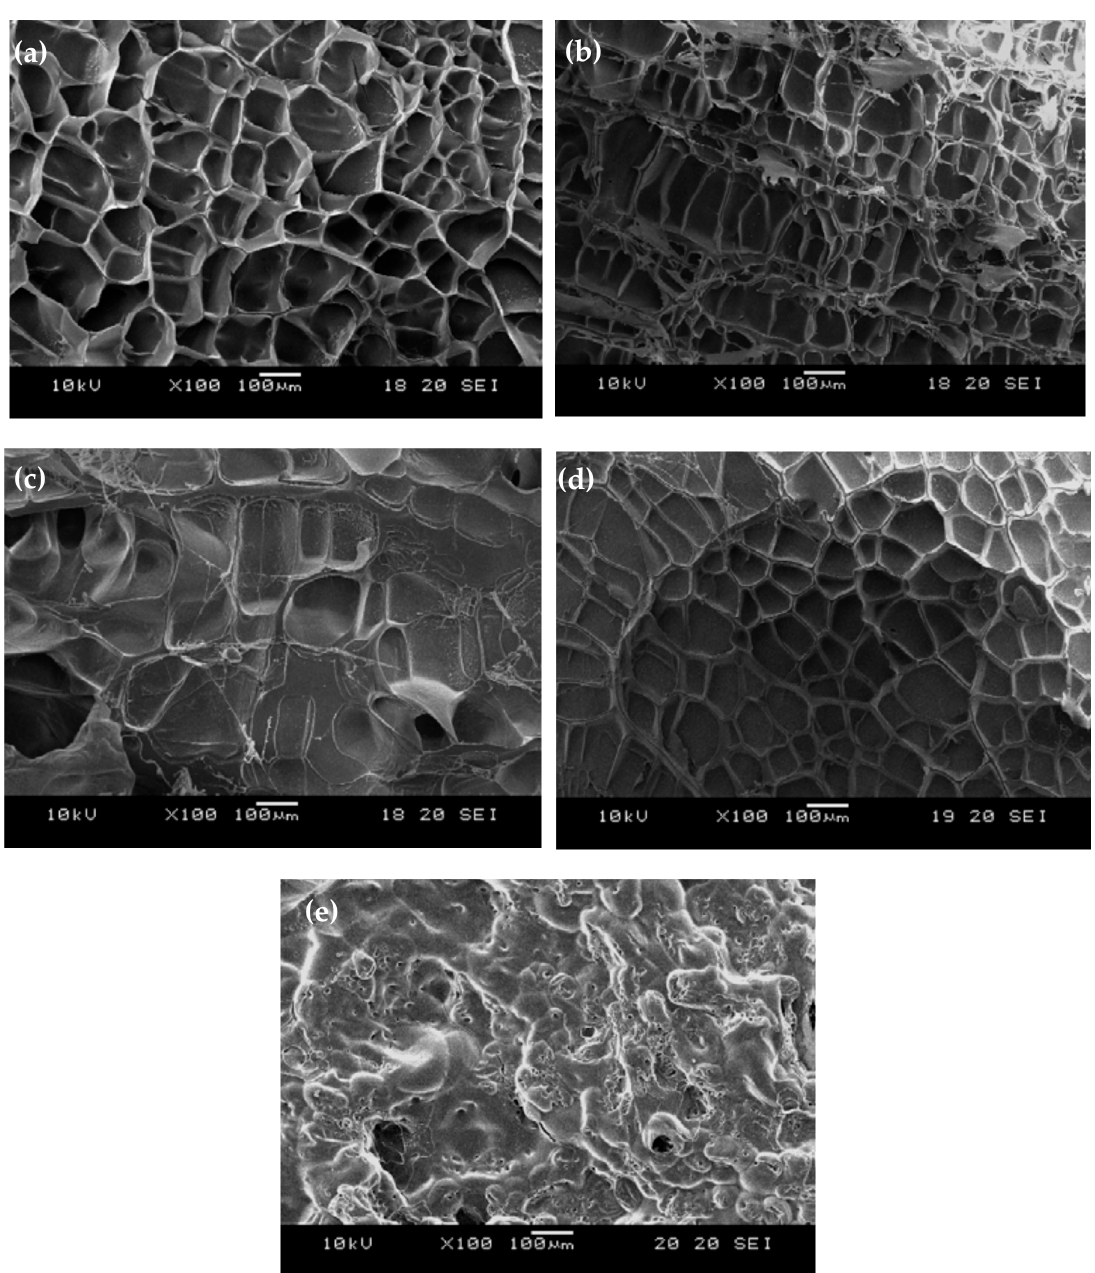
Figure 3. Scanning Electron Microscope (SEM) micrographs of freeze-dried stainless steel specimens subjected to HMDSZ plasma treatment and grafting with Poly (NIPAAm/AAc) composite hydrogels under different molar ratios of AAc. ( a ) NIPAAm (0 mol % AAc), ( b ) 1 mol % AAc, ( c ) 3 mol % AAc, ( d ) 5 mol % AAc, and ( e ) 10 mol % AAc.